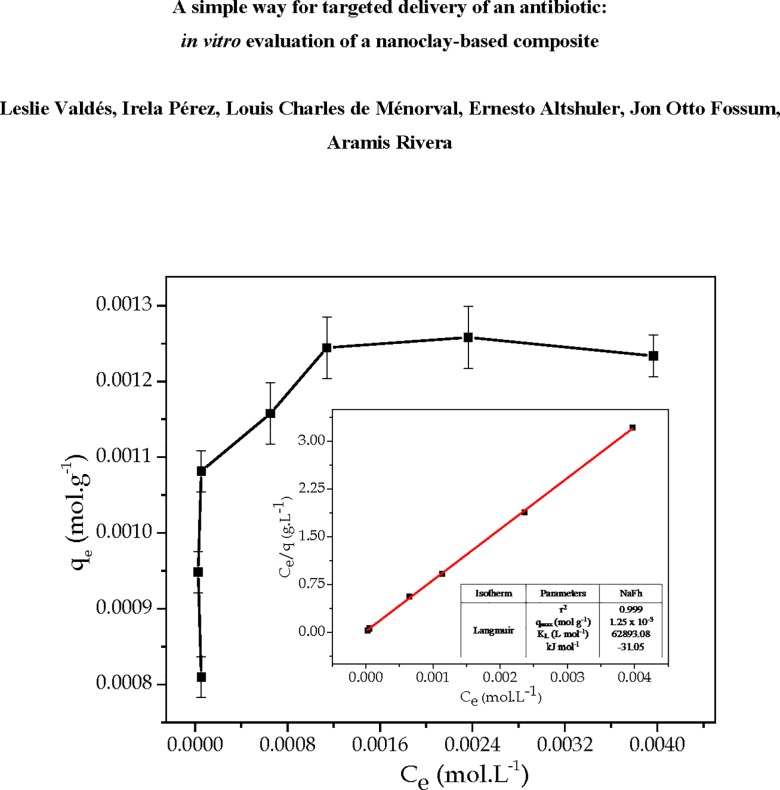
Cipro adsorption isotherms for NaFh and the parameters of adsorption isotherm models.The solid line in the inset represents Langmuir model fit.